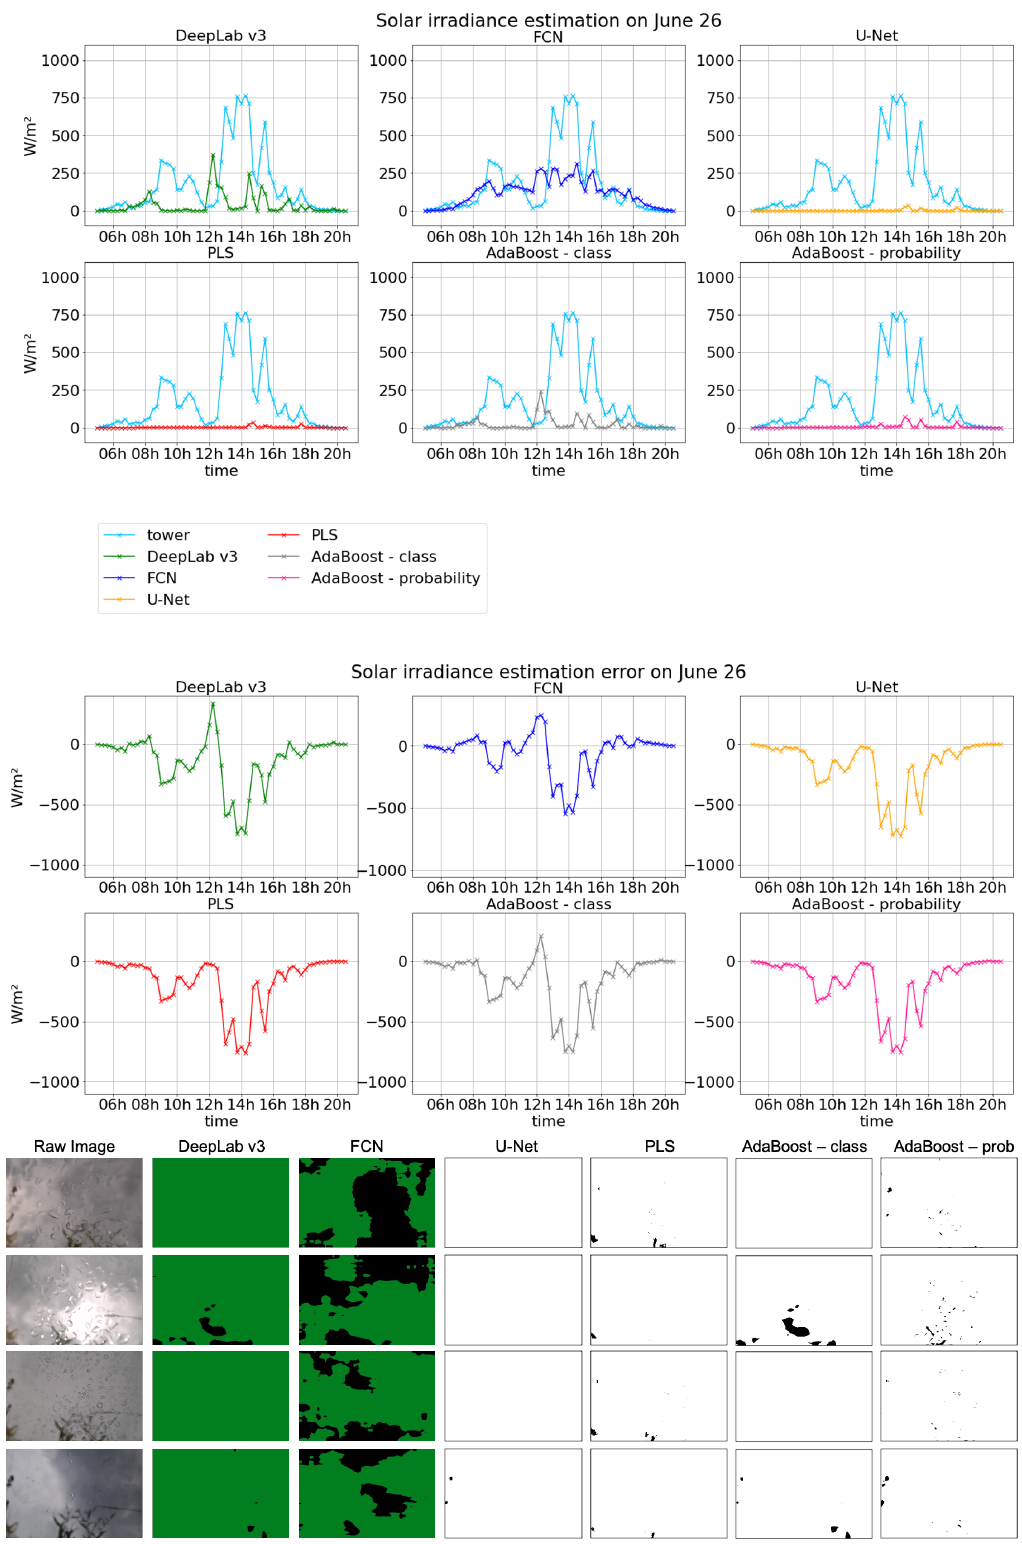
Figure A9. Solar irradiance estimation result based on cloud cover estimation from each machine learning model